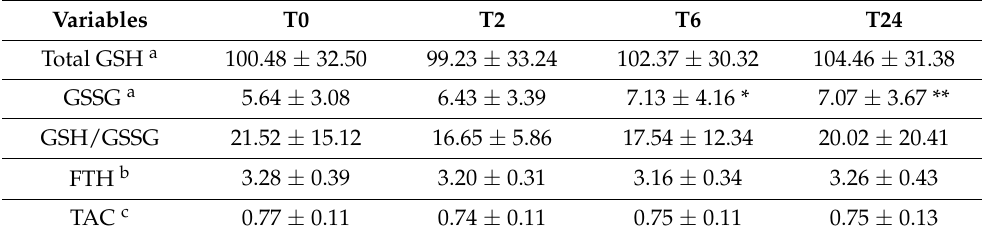
Table 3. Plasma glutathione homeostasis, free thiols levels and total antioxidant capacity. Variables T0 T2